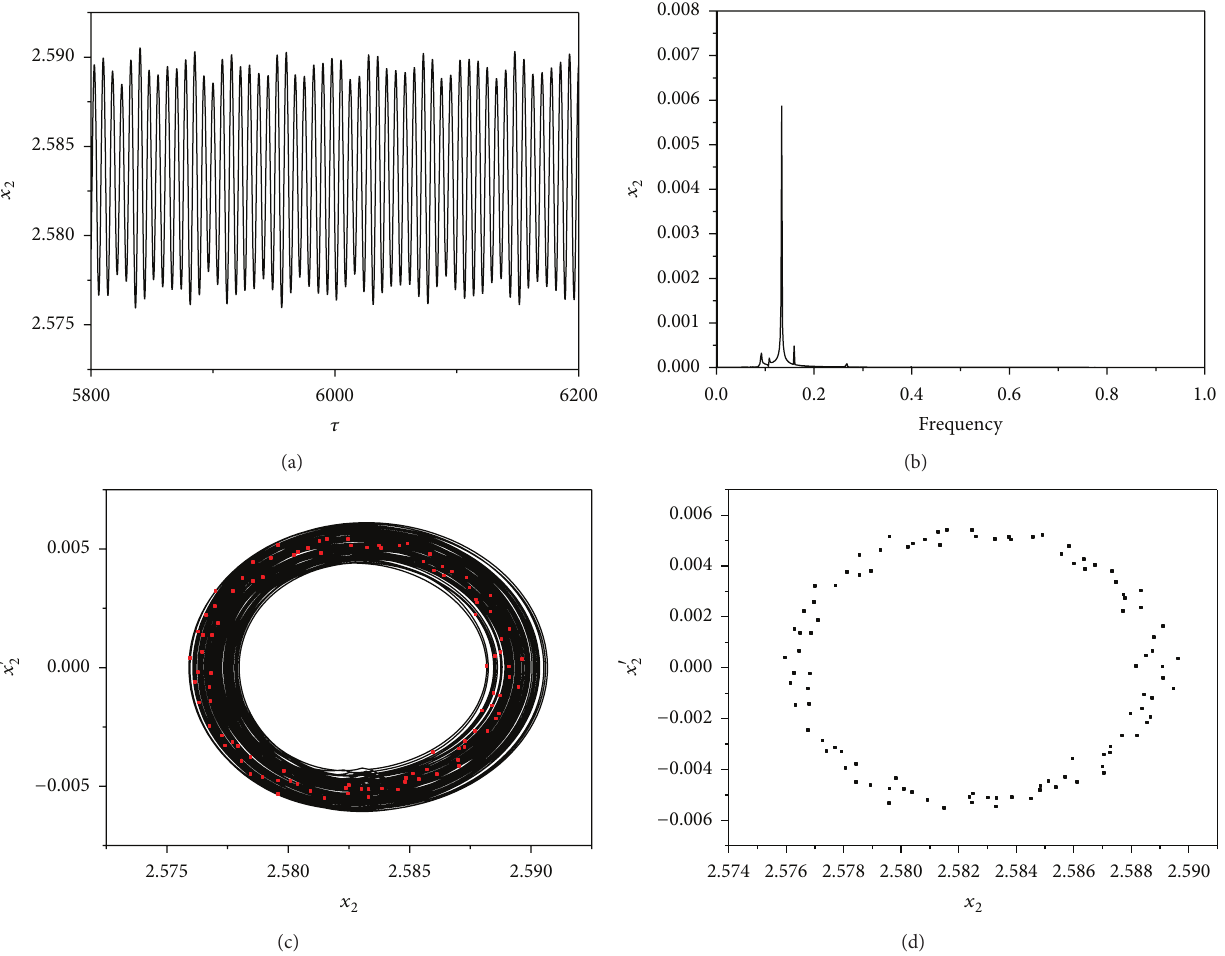
Figure 20: See 𝜔 = 1.10 . (a) Displacement response. (b) Frequency spectrum. (c) Phase-portrait plots. (d) Poincar´e maps.